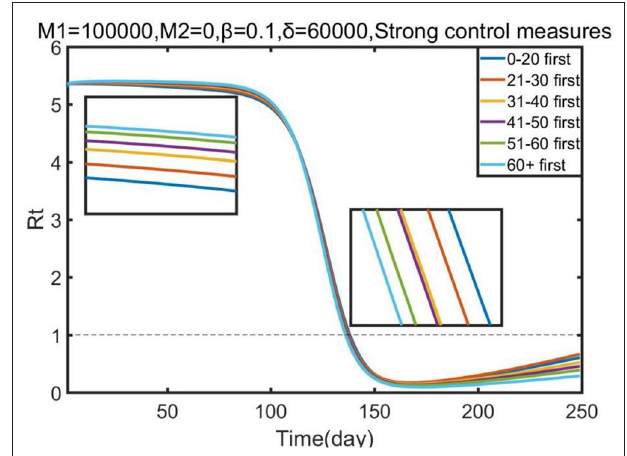
FIGURE 5 | Effect of each priority vaccination strategy on the reduction in the effective reproduction number ( R t